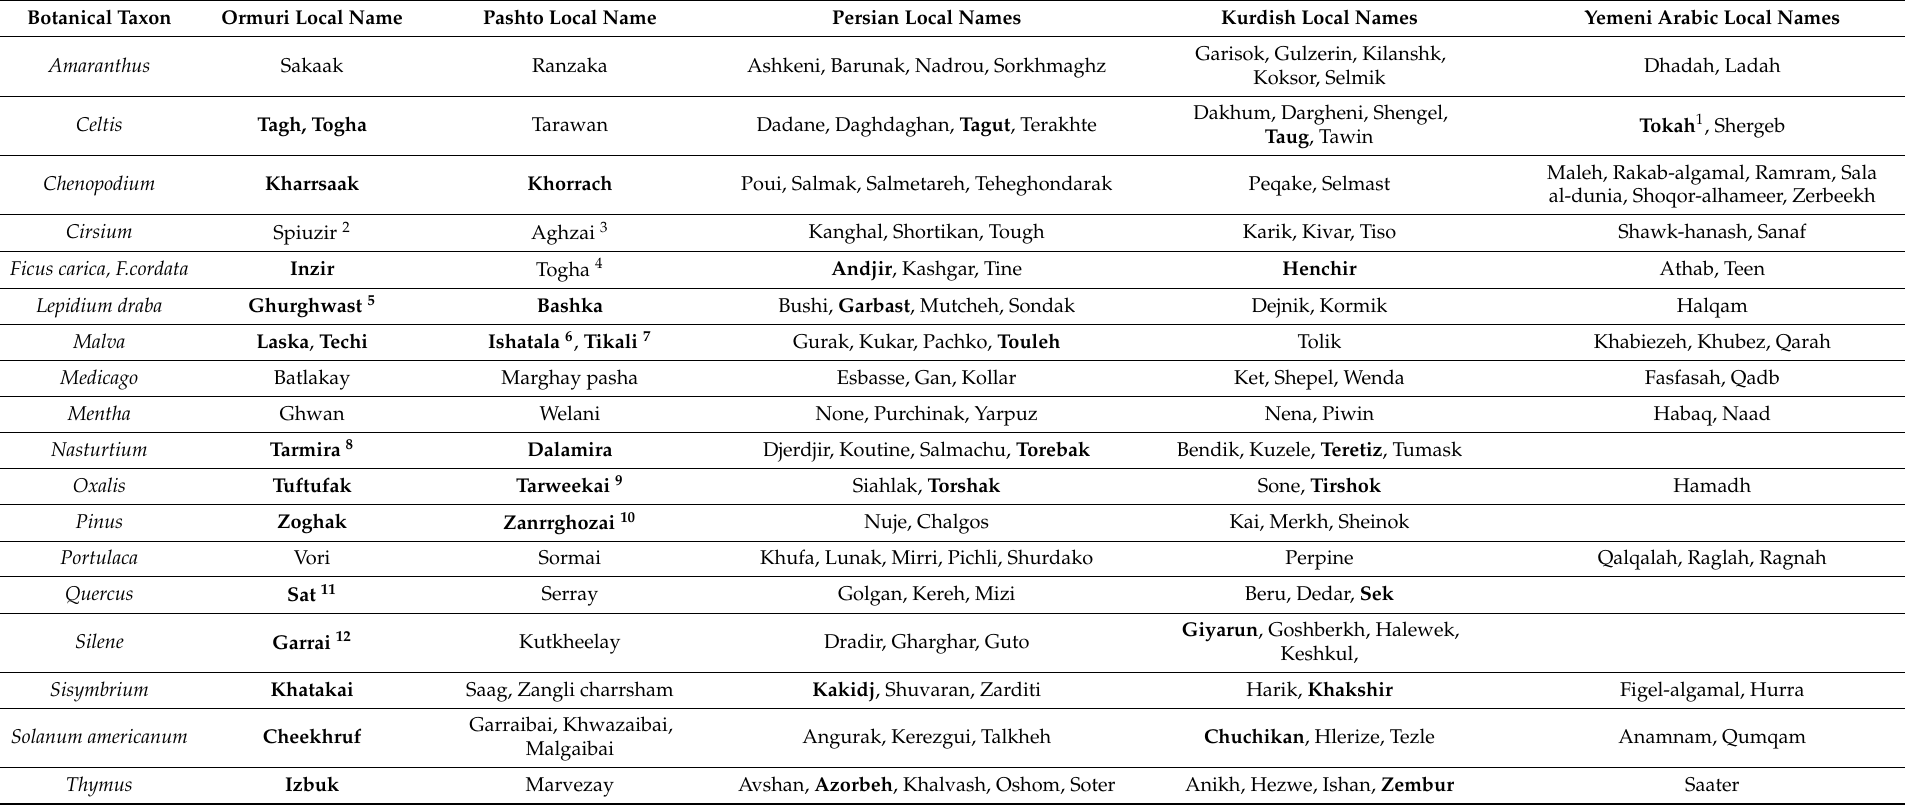
Table 2. Comparative analysis of recorded Ormuri folk wild food plant names with folk plant nomenclature in Pashto, Persian, Kurdish and Yemeni Arabic (similar phytonyms are reported in